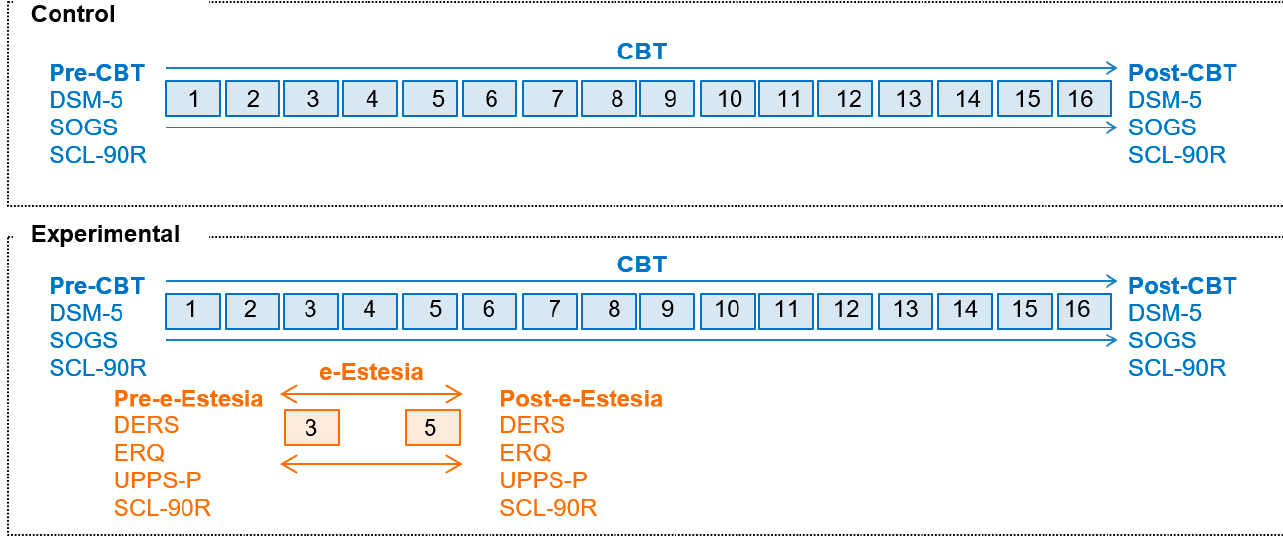
Figure 1. Scheme with the design of the study. Note. CBT: Cognitive behavioral therapy. DERS: Difficulties in Emotion Regulation Scale. ERQ: Emotion Regulation Questionnaire. UPPS-P: Impulsive. Behavior Scale. SCL-90R: Symptom Checklist-Revised. SOGS: South Oaks Gambling Severity Screen. DSM-5: number of DSM-5 criteria for gambling disorder.